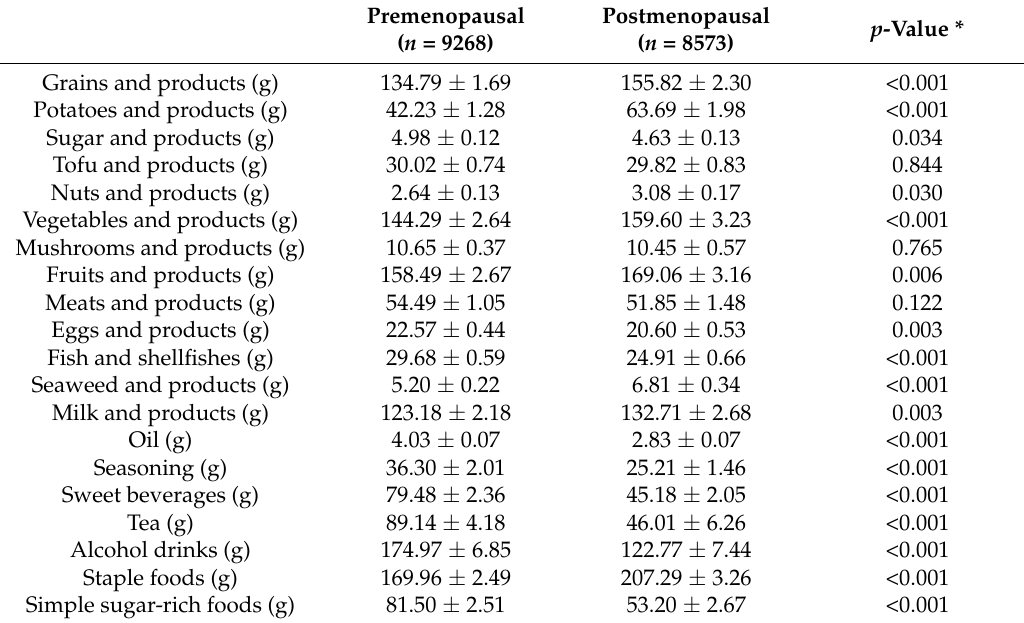
Table 2. Food group consumption in Korean women